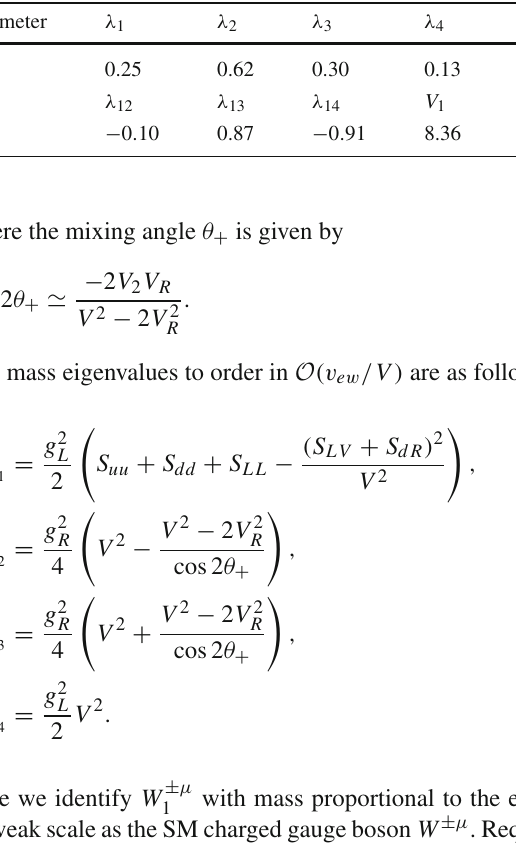
Table 1 Values of the parameters that satisfies the necessary bounded- ness conditions defined in Eqs. (34)–(37) and positivity of the square of mass matrices given in Sect. 2.3. The mass parameter in the table